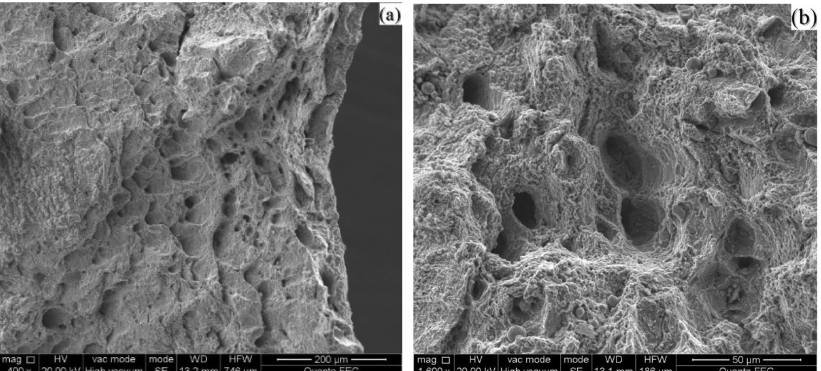
Figure 11: (a) The accumulation of tiny holes and rupture layers and (b) the growth and coalescence of